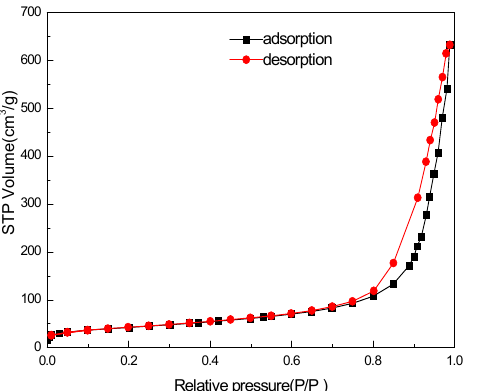
Figure 3. N 2 adsorption–desorption isotherm of the Pd–Ni/ γ Al 2 O 3 –SiO 2 bimetallic catalyst.